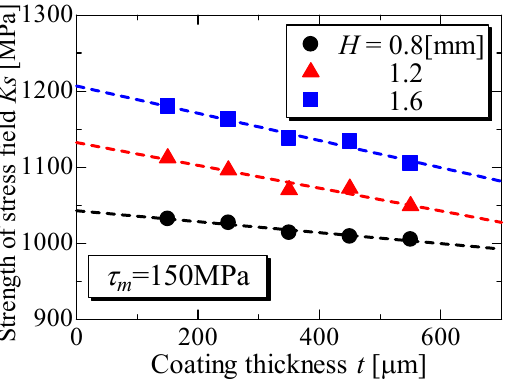
Figure 15. Influence of coating thickness on K s of the shear stress distributions under constant average shear stress condition of τ m = 150 MPa.